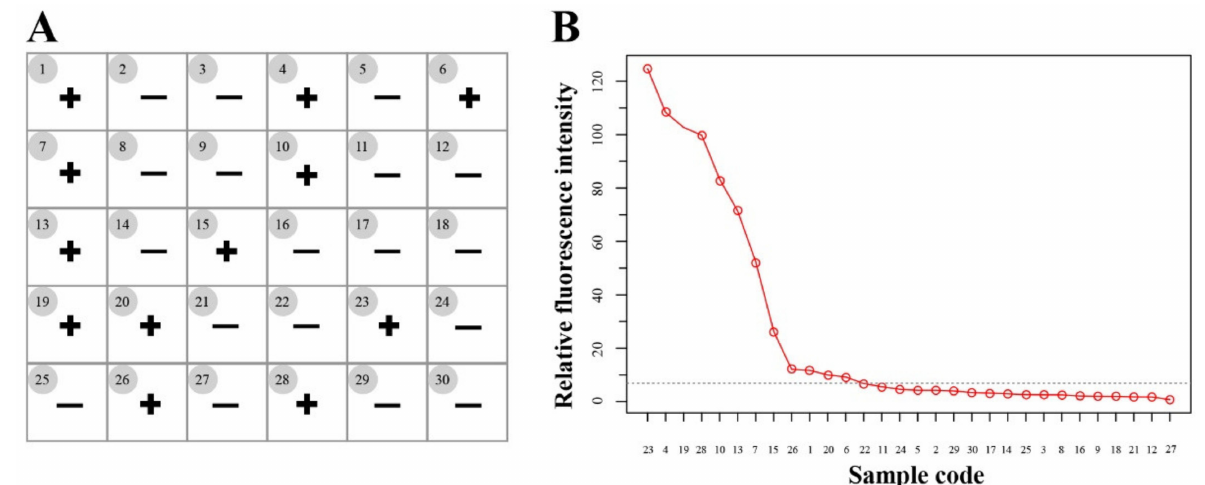
Figure 5. Application of the RAA-Cas12a-Tg system to T. gondii detection in the environment samples. ( A ) Summary of T. gondii detection in soil samples ( n = 30) using the RAA-Cas12a-Tg system. + means positive and – means negative. ( B ) 30 soil samples with relative fluorescence intensity > 9 were considered as